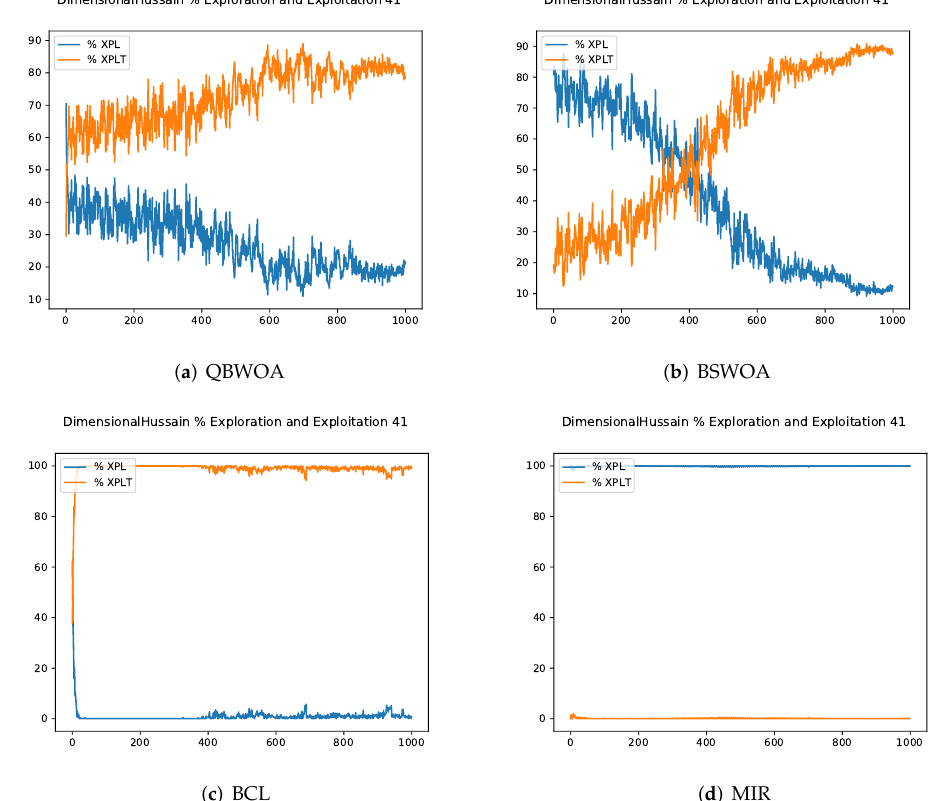
Figure 3. Percentage of exploration and exploitation of algorithms resolving the 41